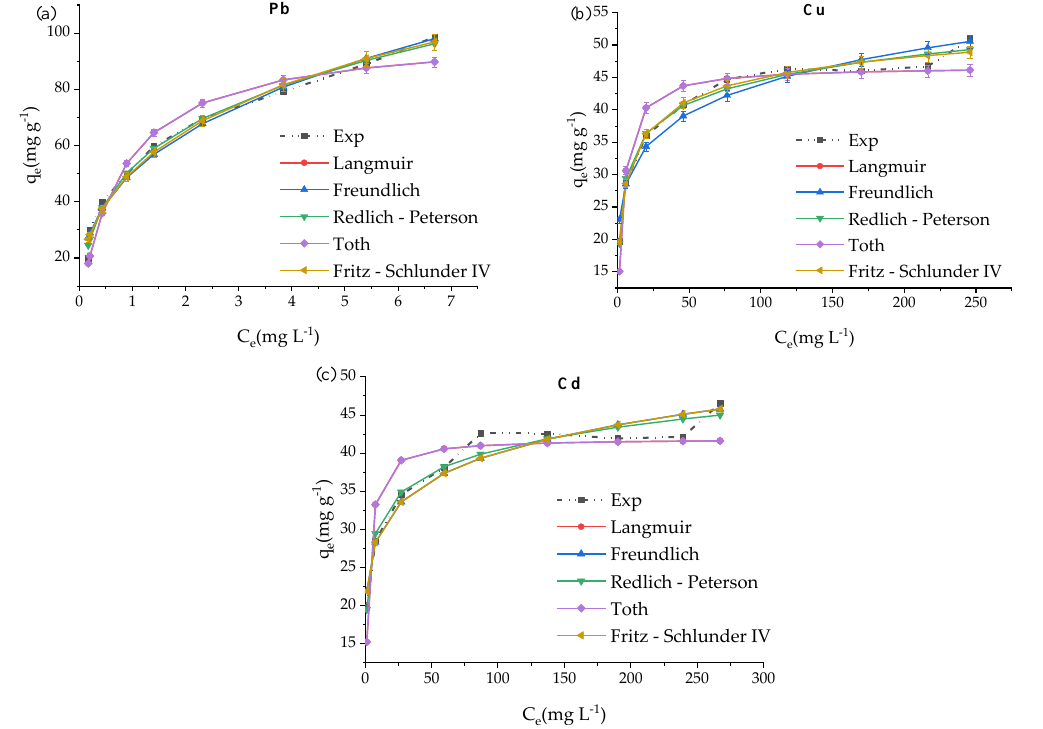
Figure 7. ZVK-FAU nonlinear adsorption isotherms plots for the simultaneous removal of five metals at 90 min, C 0 = 100 to 500 mg L − 1 and 5 g L − 1 zeolite loading for ( a ) Pb, ( b ) Cu, and ( c )